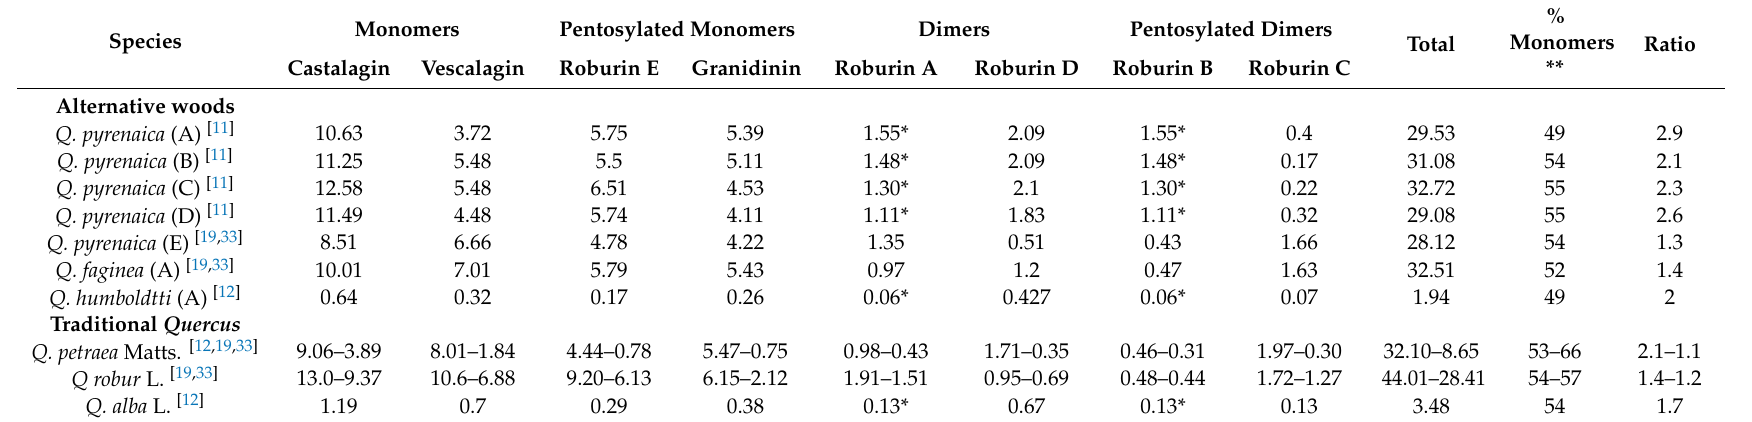
Table 2. Mean of the concentration expressed as mg / g of the ellagitannins found in green woods of di ff erent botanical origin. Monomers Species